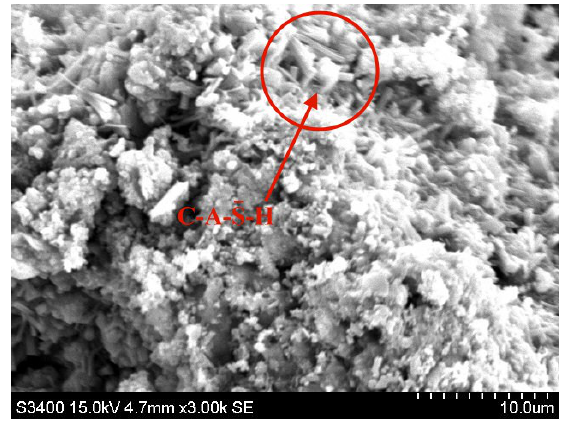
Figure 8. SEM micrograph of mixture CF and GGBS blended cement (28 days). (CF: fly ash CF, GGBS: ground granulated blast-furnace slag, C-A-S